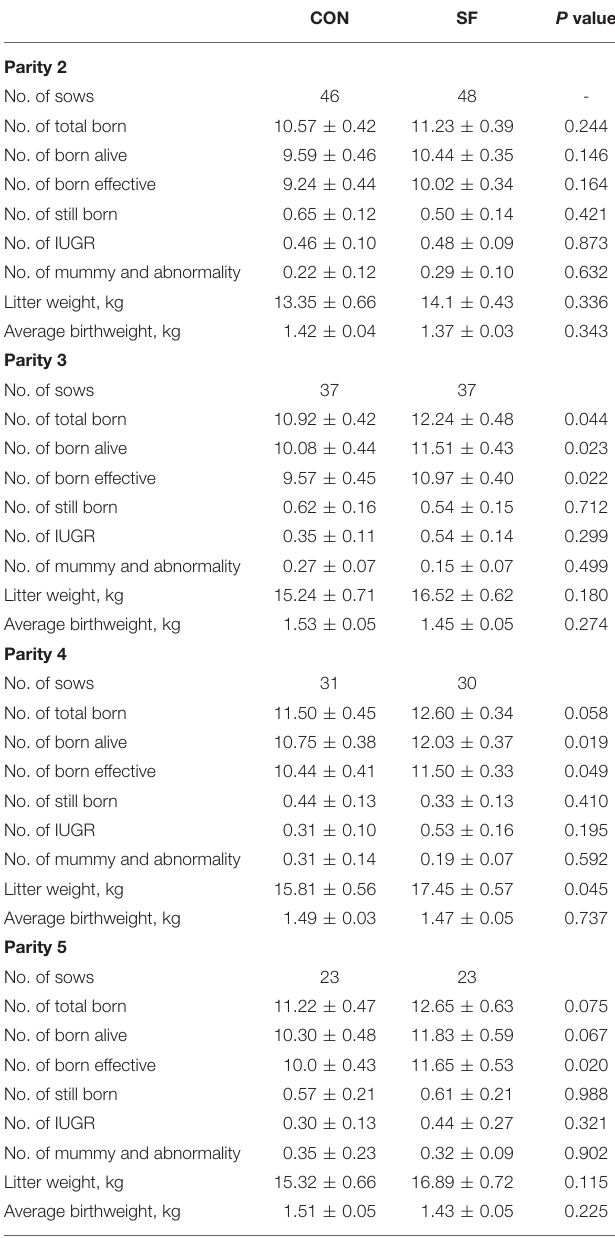
TABLE 5 | Effects of SF supplementation during the replacement phase on reproductive performance from Parities 2 to 5 a,b . CON SF P